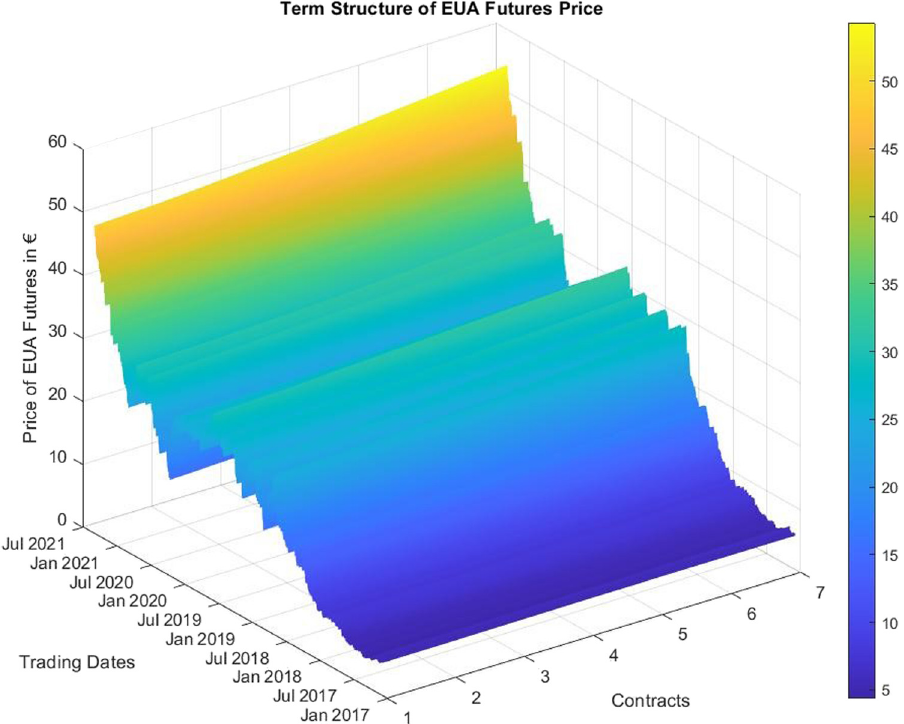
Figure 4: Term structure of EUA futures prices for seven available contracts from January 30, 2017, to April 30,